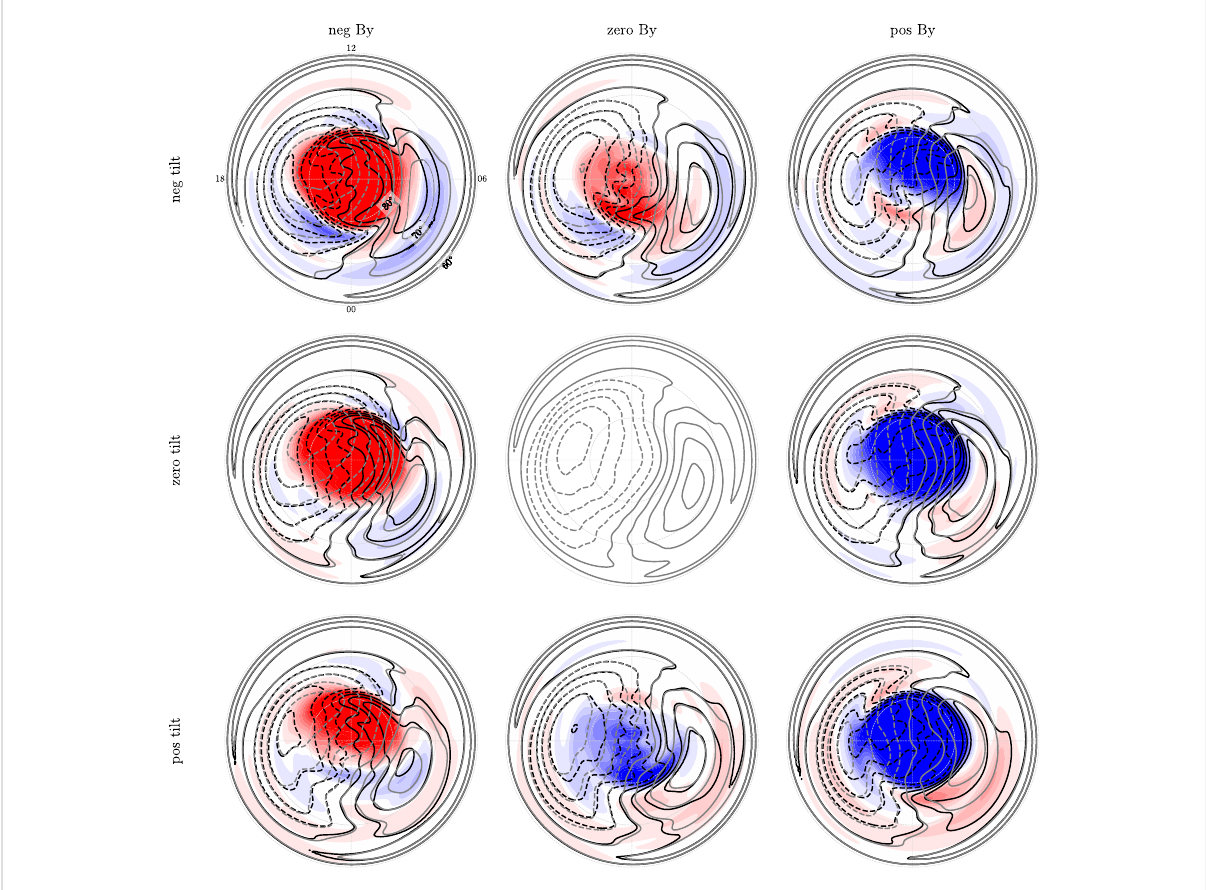
FIGURE 4 Weimer(2005a),Weimer(2005b)electricpotentialsinthesameformatasinFigure3,butwiththeNorthernhemispherepotentialsshiftedusing our estimated displacement fi eld. The red-white-blue color scale is the same as in Figure